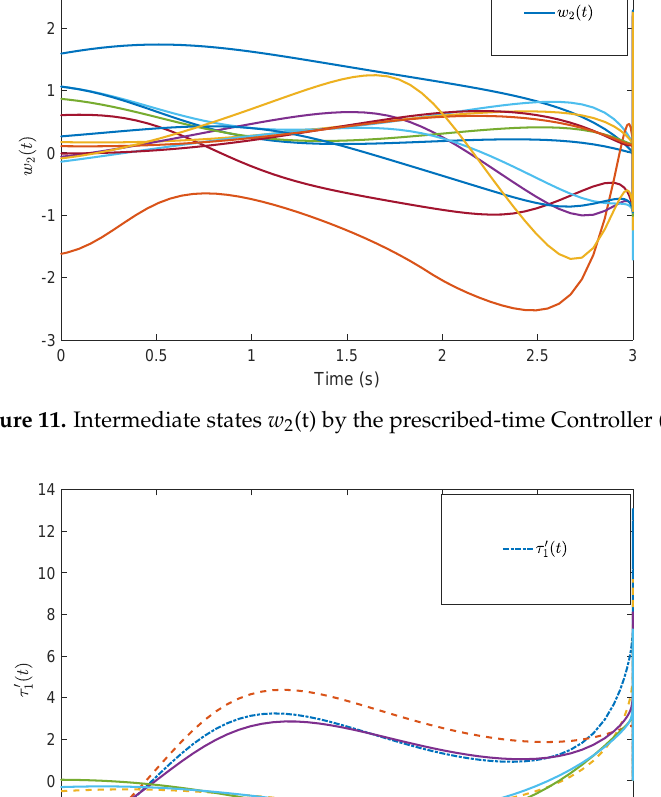
(t) by the prescribed-time Controller (62). 1